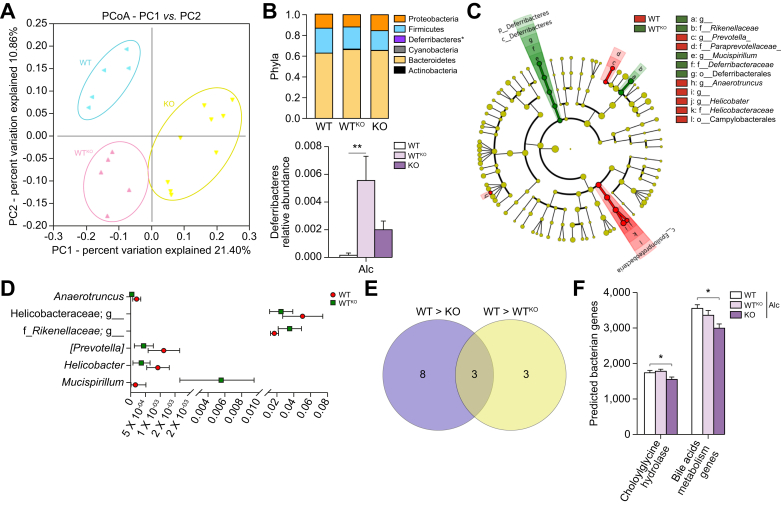
Intestinal microbiota of alcohol-fed mice transplanted with the IM of TGR5-deficient mice. WT, KO, and WTKO mice were fed alcohol. (A) Unweighted PCoA Unifrac distances showing the composition of the IM (ANOSIM test, p = 0.001). (B) Histogram showing the relative abundance between phyla (FDR test, p <0.05) (upper panel) and Deferribacteres (FDR test, p <0.05) (lower panel). (C–E) Comparisons between WT and WTKO mice. (C) Cladogram showing taxa with the largest differences in abundance (LDA >2). (D) Plot showing differences in the relative abundance of taxa. (E) Venn diagram showing common taxa. (F) Predictive expression of choloylglycine hydrolase and BA metabolism genes. Kruskall-Wallis test and Dunn’s multiple comparison post-hoc test, ∗p <0.05. WT n = 5, WTKO n = 5, KO n = 9. BA, bile acid; IM, intestinal microbiota; KO, knockout; LDA, linear discriminative analysis; PCoA, principal coordinate analysis; WT, wild-type.